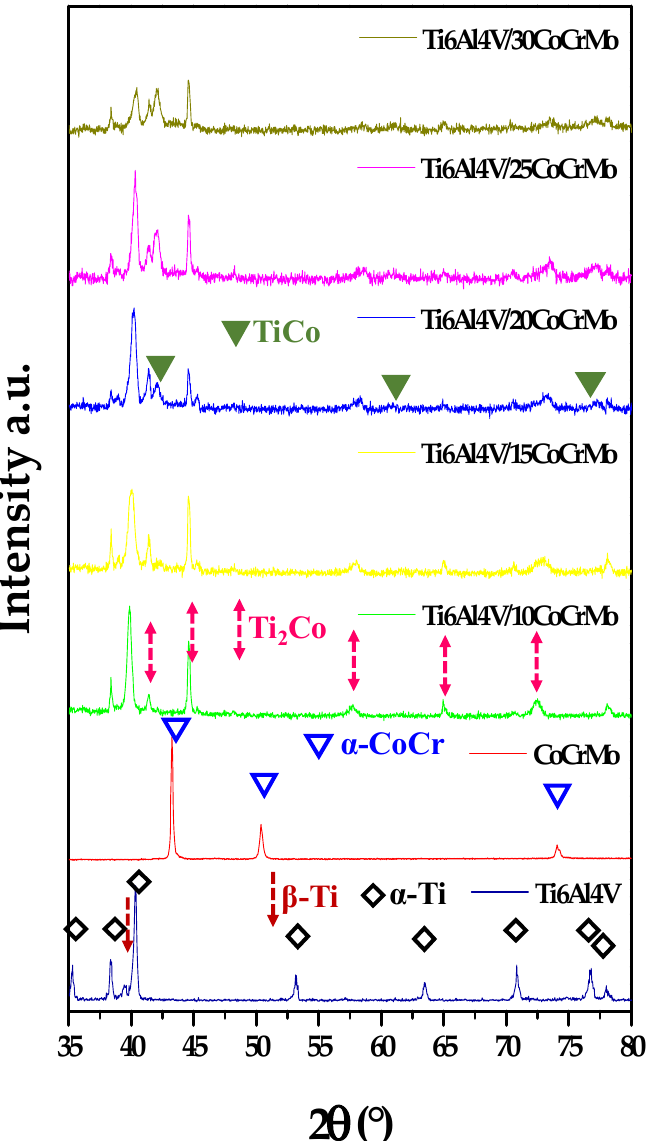
Figure 10. X-ray patterns of Ti6Al4V and CoCrMo powders before sintering and composite samples after sintering.